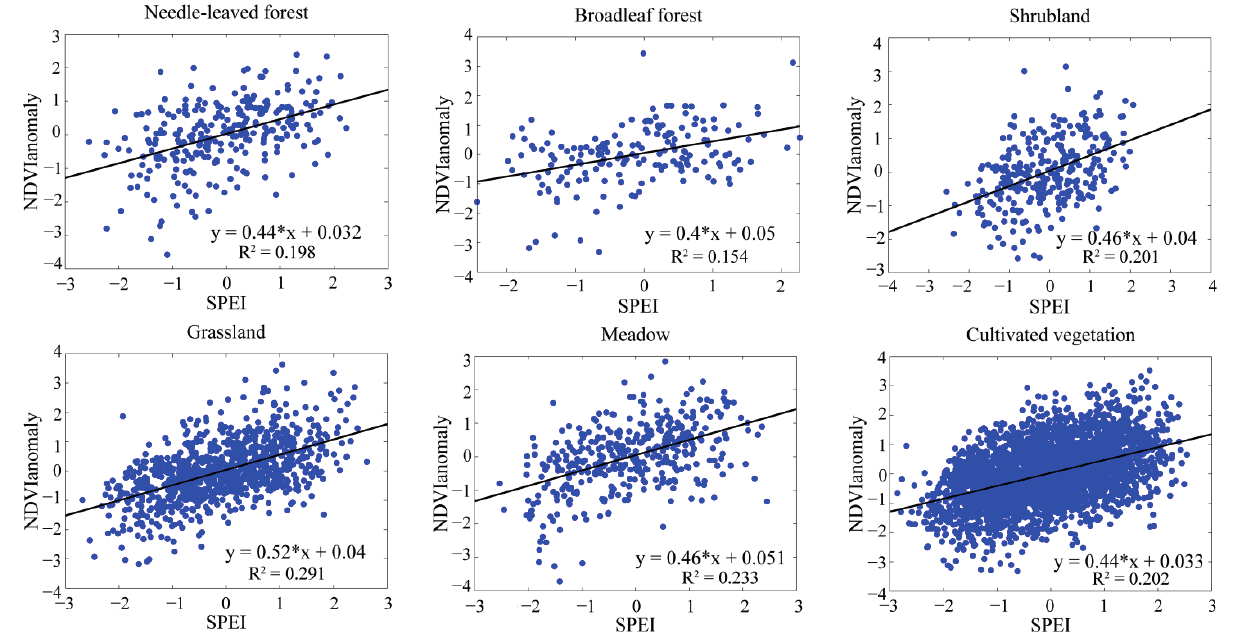
Figure 7. The responses of vegetation to the drought based on the SPEI opt